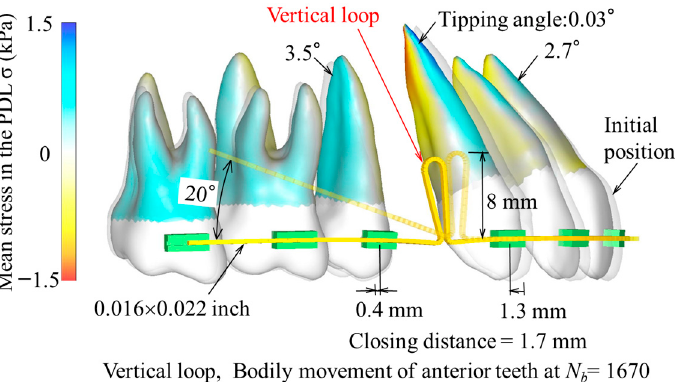
Figure 7. Replacement of helical loop with a vertical loop. Closing distance C and the number of repeated calculations N b decreases.